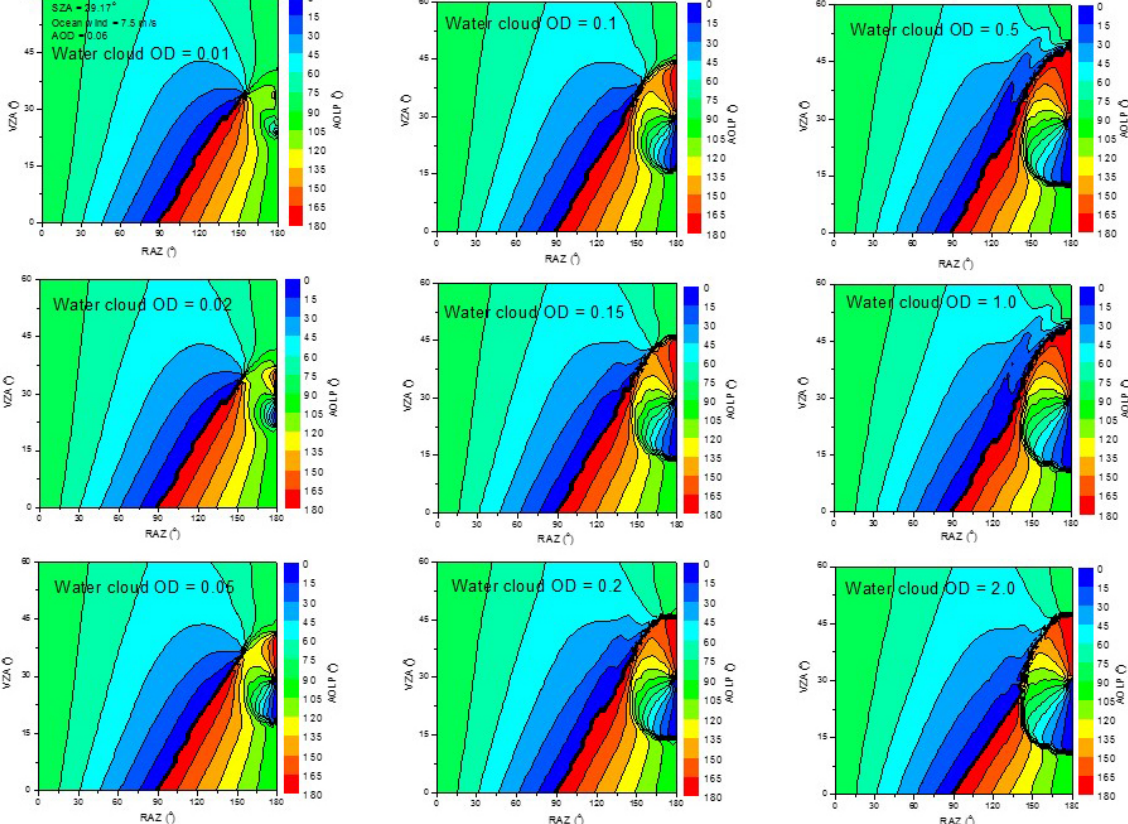
Figure 1. The angle of linear polarization (AOLP) of reflected sunlight at 670nm from water clouds showing that even clouds with optical depths (OD) of 0.01 exhibit the near-backscatter p -polarization feature. In the ADRTM modeling, the clouds’ ODs are set from 0.01 to 2.0, the ocean wind speed is assumed to be 7.5ms − 1 , the solar zenith angle (SZA) is 29.17 ◦ , and the aerosol optical depth (AOD) is 0.06. The C1 size distribution (Deirmendjian, 1969) is used for water cloud